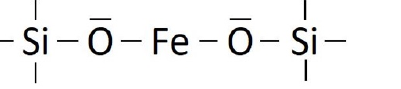
Figure 11. Cation bridge of Fe 2+ and tetrahedra SiO 44+ in fayalite slag [16].